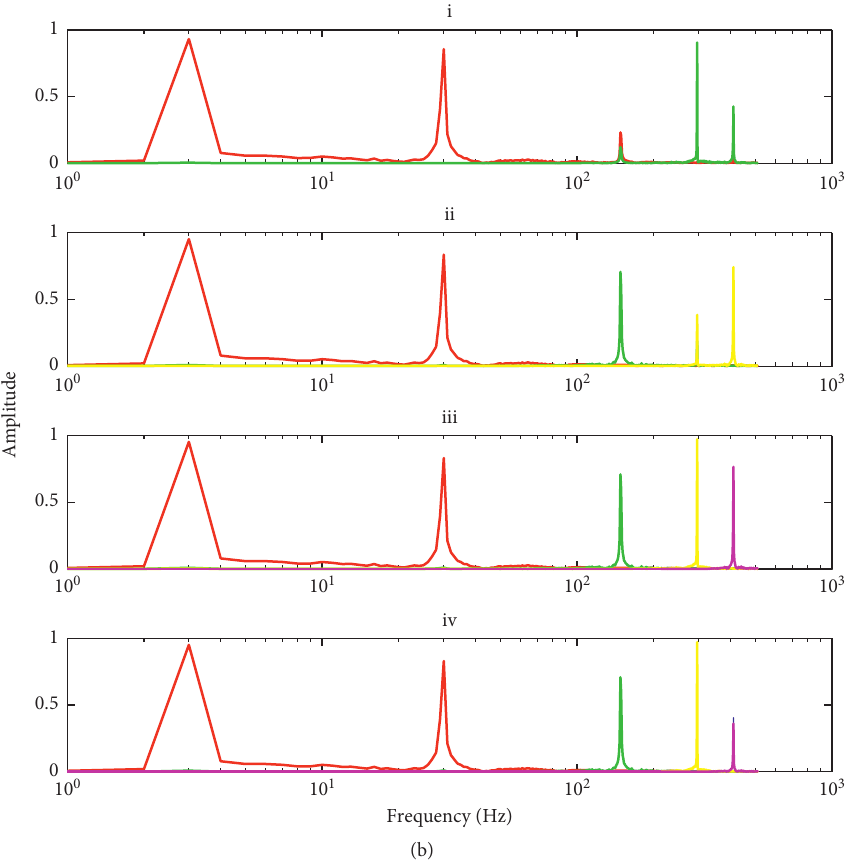
Figure 1: VMD decomposition results under different parameters. (a) α � 1000 with (i) K � 2, (ii) K � 3, (iii) K � 4, and (iv) K � 5. (b) α � 500 with (i) K � 2, (ii) K � 3, (iii) K � 4, and (iv) K �